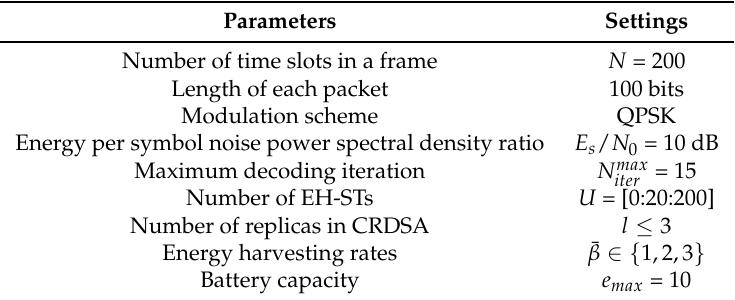
Table 1. Simulation parameters. EH-ST: Energy harvesting satellite terminal.